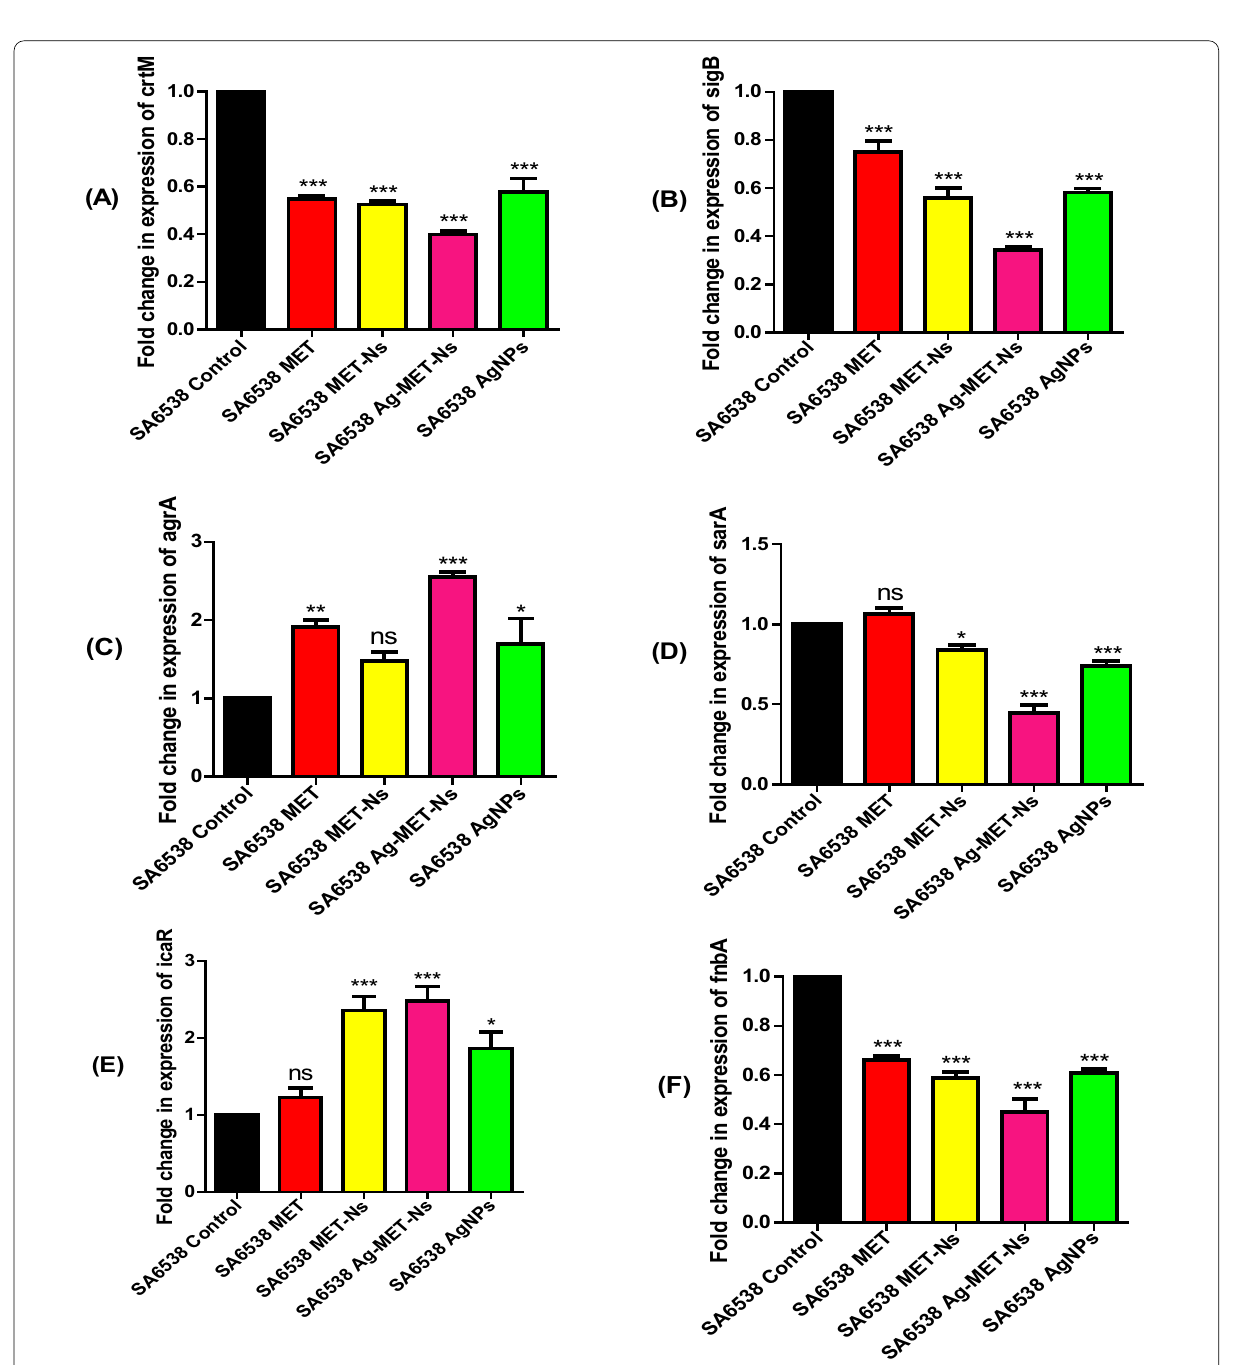
Fig. 4 Downregulation of S. aureus QS genes by tested agents. A crtM , B sigB , C agrA , D sarA , E icaR and F fnbA using sub-MICs of the tested agents compared to controls. The data shown are the means standard errors of three biological experiments with three technical replicates each. ± * P < 0.05, ns;